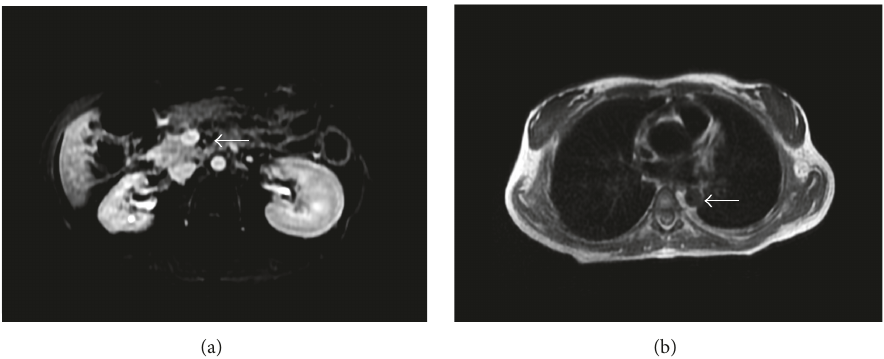
Figure 3: MRI and MRA of the abdomen and pelvis were obtained. (a) LAVA postcontrast sequence demonstrates mural thickening and marked luminal narrowing of the superior mesenteric artery. (b) Axial double inversion recovery sequence demonstrates increased focal narrowing of the descending thoracic aorta, measuring 1.6 cm in diameter. The white arrow represents in (a) SMA and in (b) descending thoracic